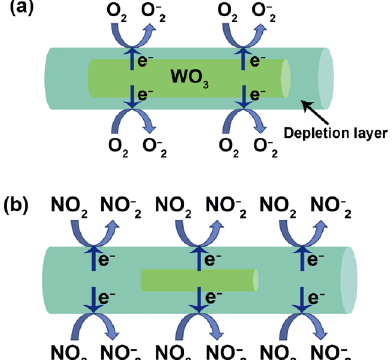
Fig. 9 Schematic diagram of gas-sensing mechanism for WO 3 nanomesh sensor: (a) in air and (b) in air with NO 2 .